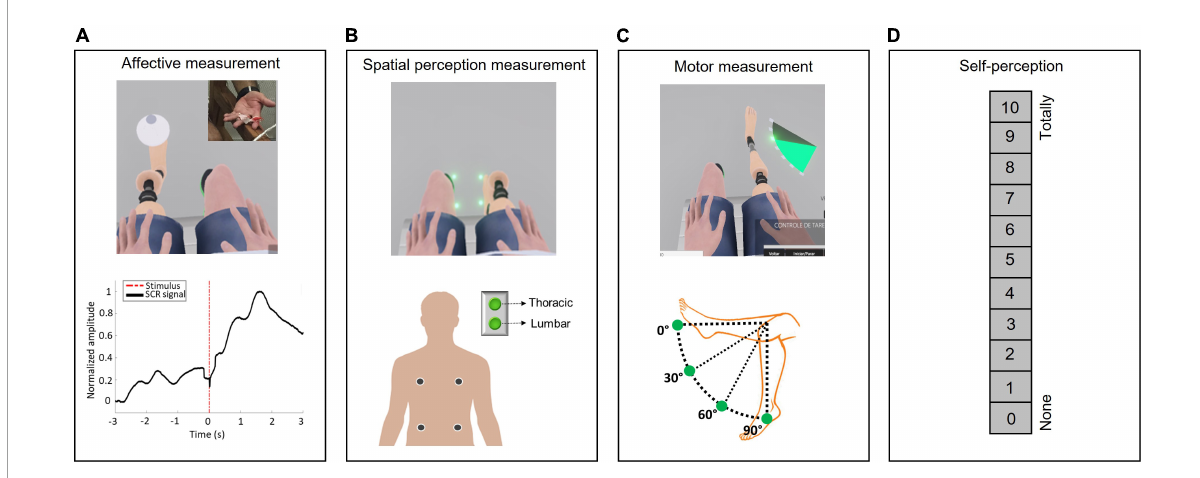
FIGURE3 Embodiment assessment. (A) Affective measurement–Skin conductance response. Two surface electrodes were placed on the intermediate phalanges of the second and third left hand fingers, and the SCR was recorded once a chandelier dropped on the virtual prosthesis, representing a threatening stimulus. (B) Spatial perception measurement–Crossmodal congruency task (CCT). During the CCT, visual stimuli were applied within the VR environment close to the avatar’s feet (close to the hallux or heel) soon after the appearance of the visual distractor, and a vibratory stimulus was applied on the participant’s back (thoracic or lumbar). The CCT was composed of sixteen different combinations of visual and vibrotactile stimuli, each presented four times at random, for a total of sixty-four trials. The participants were instructed to press a button corresponding to the location on their back where they received the vibratory stimulation as quickly as possible while ignoring the visual distractor. (C) Motor measurement. The participants moved the virtual prosthesis until they reached a specific predetermined position set at four target angles: 0 ◦ , 30 ◦ , 60 ◦ , or 90 ◦ . The participants’ performances, execution time and success rates during the training were used to assess their ability to control the virtual prosthesis. (D) Self-perception. The participants quantified on a scale from 0 to 10, where 0 indicated “none” and 10 indicated “totally,” how much they felt the virtual prosthesis was part of their own body and how much they felt that they could control